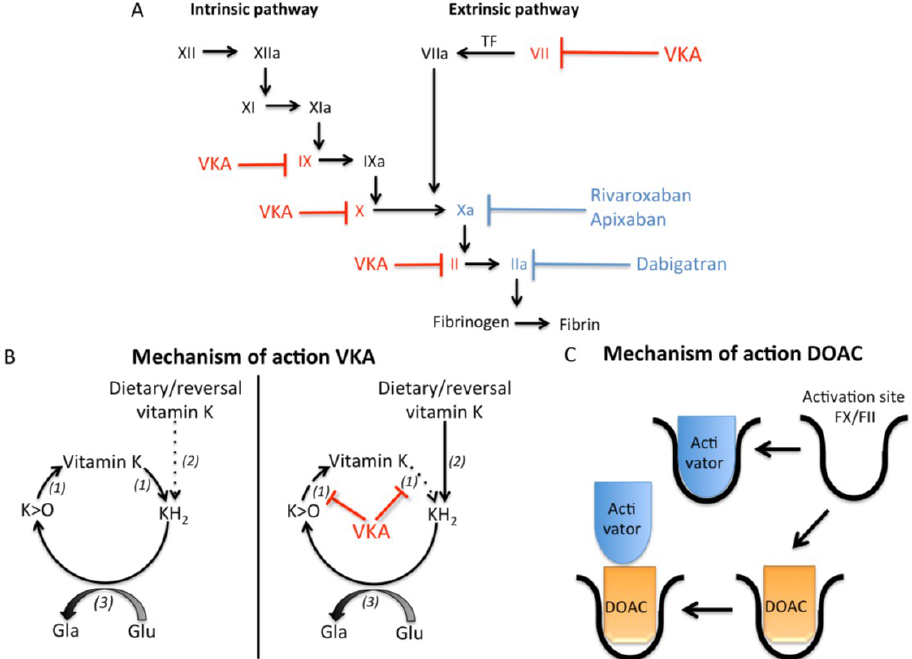
Figure 1. Effects of vitamin K antagonists and direct oral anticoagulants on coagulation. ( A ) The coagulation cascade can be activated by both the intrinsic and extrinsic pathway, which finally results in activation of thrombin and subsequently fibrin formation. Vitamin K antagonists (VKA) induce anticoagulation via inhibiting activation of the coagulation factors depicted in red (factors X, IX, VII, and II). Direct oral anticoagulants (DOACs) induce anticoagulation via blocking the activity of coagulation factors Xa (rivaroxaban and apixaban) and IIa (dabigatran) depicted in blue; ( B ) Vitamin K cycle is required to carboxylate, and thus activate, vitamin K dependent